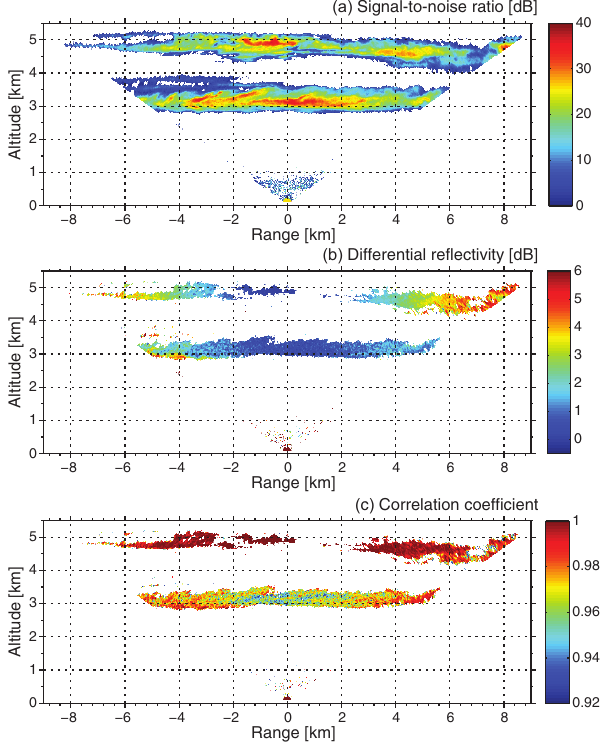
Figure 14. Range–altitude cross sections of (a) signal-to-noise ra- tio, (b) differential reflectivity Z DR , and (c) correlation coefficient ρ HV , taken at Cabauw, the Netherlands, from 18:16 to 18:20UTC on 20 October 2014. Shown parameters are calculated for the max- imum spectral lines (spectral